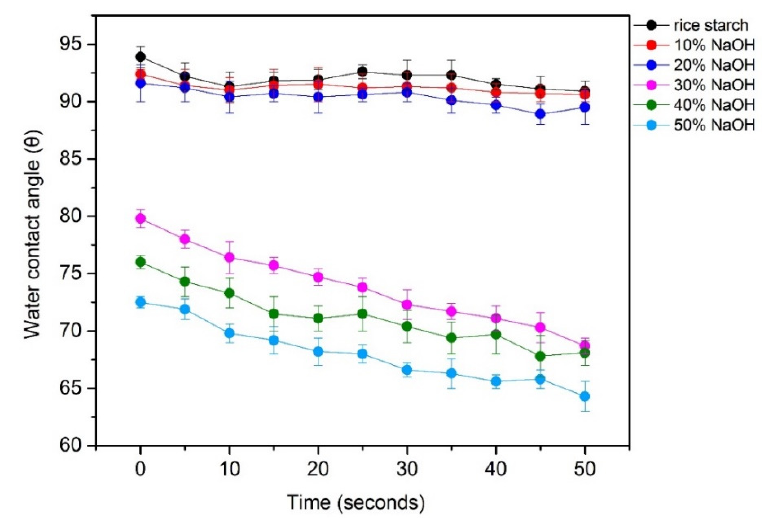
Figure 7. The dynamic water contact angle of %SM on native rice starch film and CMSr films synthesized with 10%, 20%, 30%, 40%, and 50% NaOH concentrations with time (0–50 s).